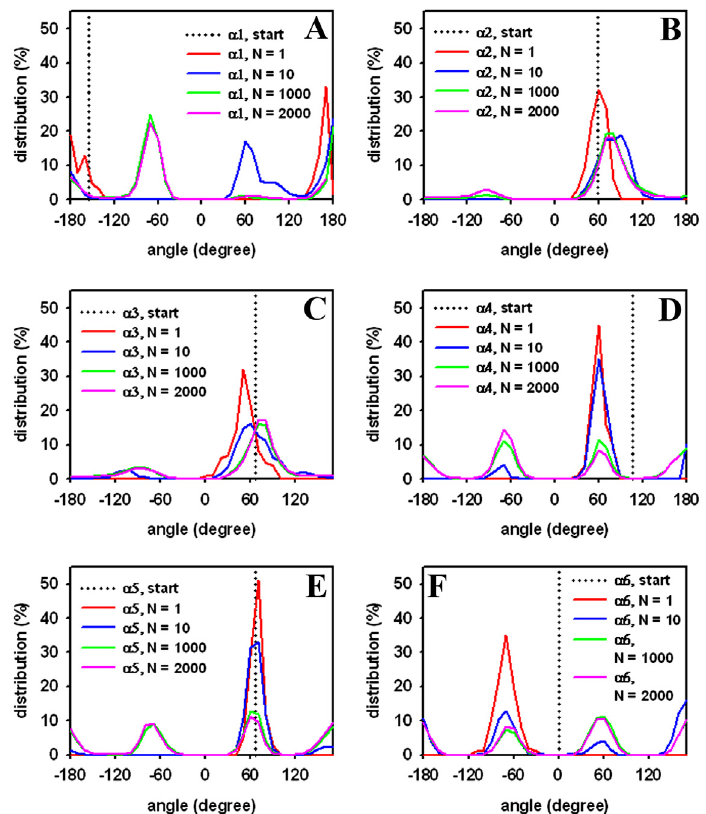
Figure 4. Distribution of DPPC head group dihedral angles from a single-molecule simulation. Head group torsions were defined as in Vanderkooi et al . [84] with the starting value defined by the initial conformation (dotted lines, “start”; compare Figure 2A). The percentage of occupation was calculated as function of torsion angle (in degree) after 1000 (“ N = 1”, red line), 10,000 (“ N = 10”, blue line), one million (“ N = 1000”, green line), and two million (“ N = 2000”, pink line) MC steps, respectively. The dihedral angles are ); ( B ) atom 5 and 6 ( α ); ( C ) atom 4 and 5 defined as ( A ) torsions around atom 6 and 7 ( α 1 2 ( α ); ( D ) atom 3 and 4 ( α ); ( E ) atom 2 and 3 ( α ); and ( F ) atom 1 and 2 ( α ), respectively 3 4 5 6 (compare Figure 2 for atom numbering in the DPPC